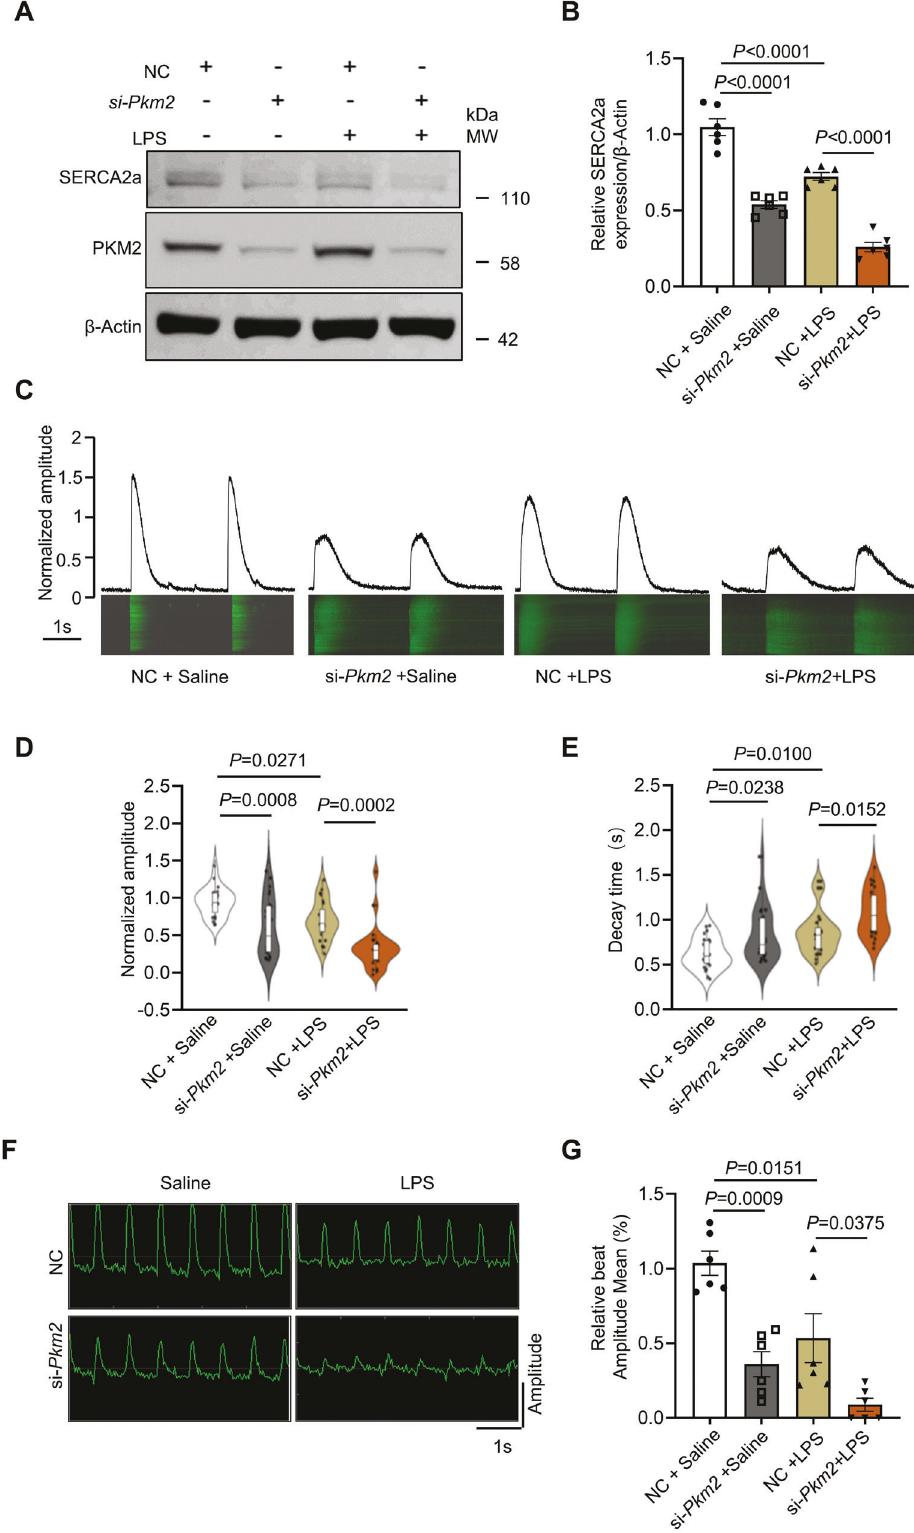
Fig. 5 PKM2 knockdown compromised cardiomyocyte contraction amplitude, calcium transients in NRCMs. A , B Western blot and quantitation of SERCA2a and PKM2 expression in NRCMs co-administered with Pkm2 siRNA and LPS. β -Actin served as loading control, n = 6. C – E Representative calcium transient curve and quantitation of calcium transient amplitudes and decay time in NRCMs, n = 24. F , G Assessment of the contractility of NRCMs co-administered with Pkm2 siRNA and LPS. Contractility waveform shows contraction amplitude of cardiomyocytes, n = 6. NC negative control. Values represent the mean ± SEM of at least three independent